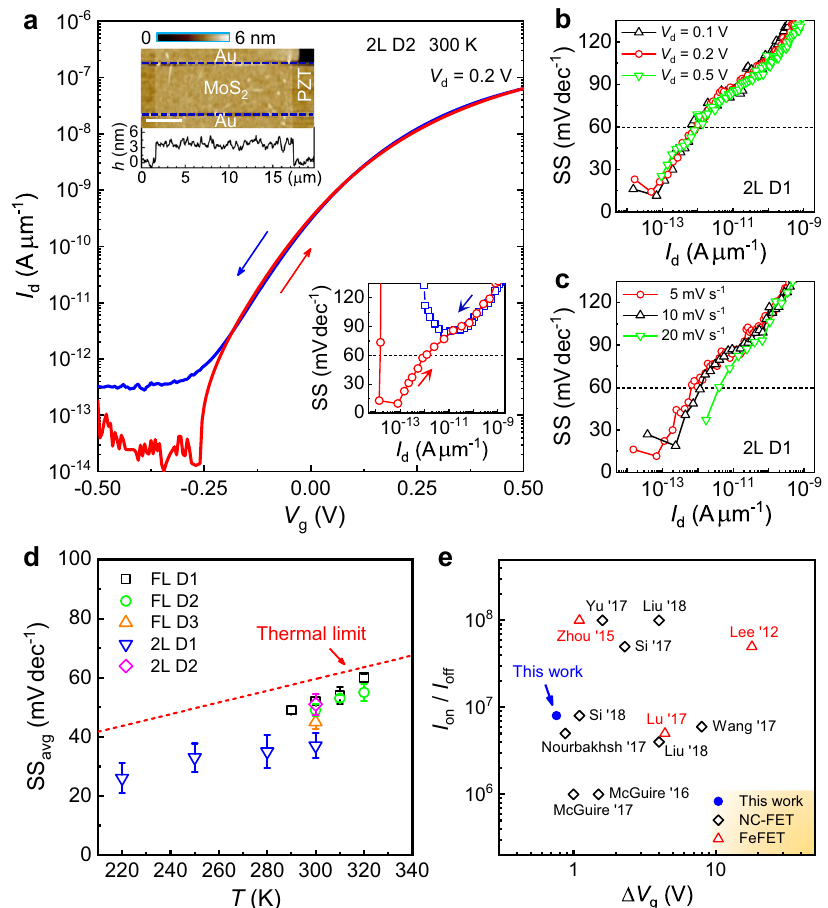
Fig. 3 Performance of the MoS 2 NC-FETs. a Transfer characteristics of a bilayer MoS 2 FET (2L D2) at 300 K in both forward and reverse V g - sweeps at scan rate of 5 mV s − 1 . Top inset: AFM topography image of the device with the height pro fi le averaged over the entire channel (lower panel). Scale bar represents 4 µm. Bottom inset: The corresponding point-by-point SS vs . I d . The dashed line depicts the thermal limit for SS at 300 K. b , c Point-by-point SS vs . I d taken on Device 2L D1 extracted at b different V d and c different V g -scan rates. d SS avg vs . T taken on three few-layer and two bilayer MoS 2 FETs, including the data shown in Fig. 2 and ( a – c ). The red dashed line depicts the theoretical Boltzmann limit of SS. e Current on/off ratio vs. required Δ V g taken from the current work (solid symbol) and those from literature (open symbols) 8 – 14,18,24,25,27